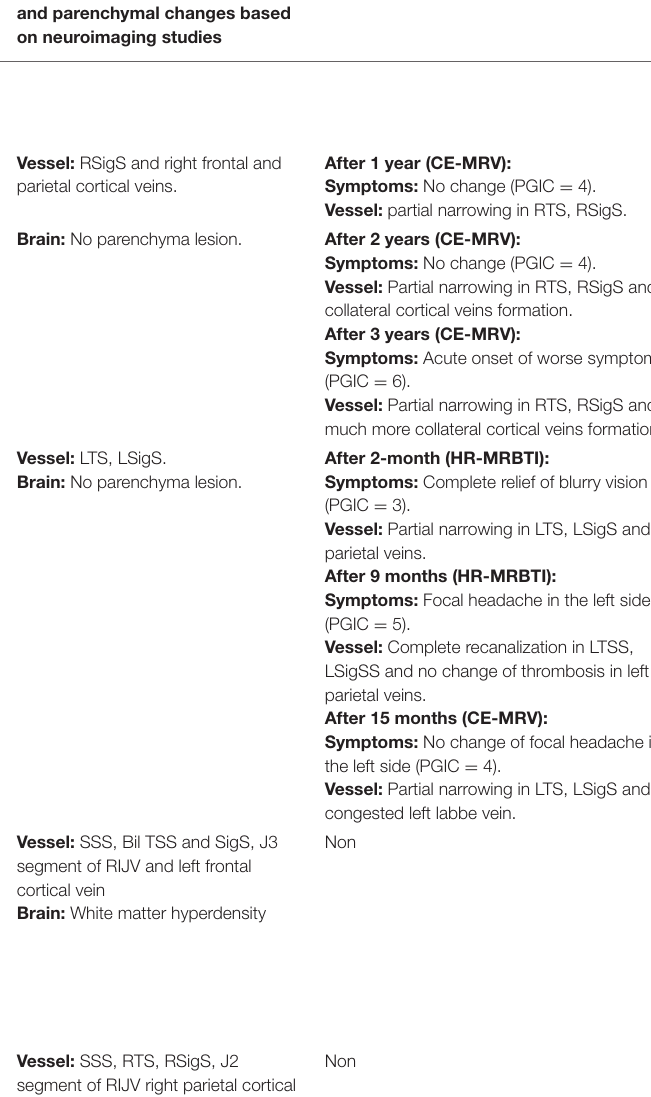
After 1 year (CE-MRV): Symptoms: No change (PGIC = 4). Vessel: partial narrowing in RTS, RSigS.